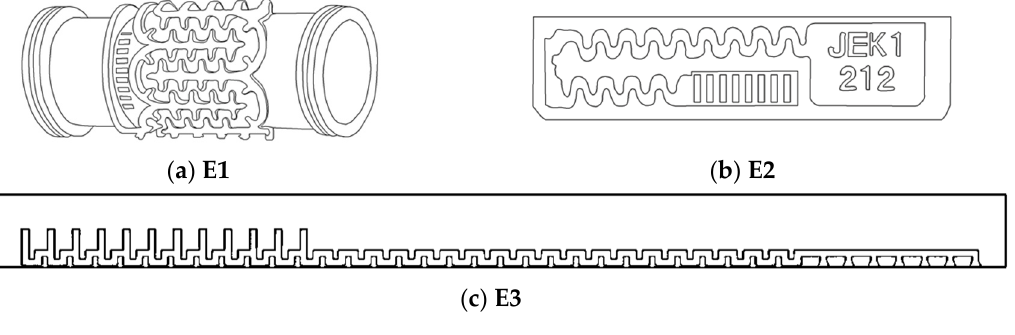
Figure 1. Emitters. ( a ) The internal channel structure of the E1; ( b ) The internal channel structure of the E2. ( c ) The internal channel structure of the E3.